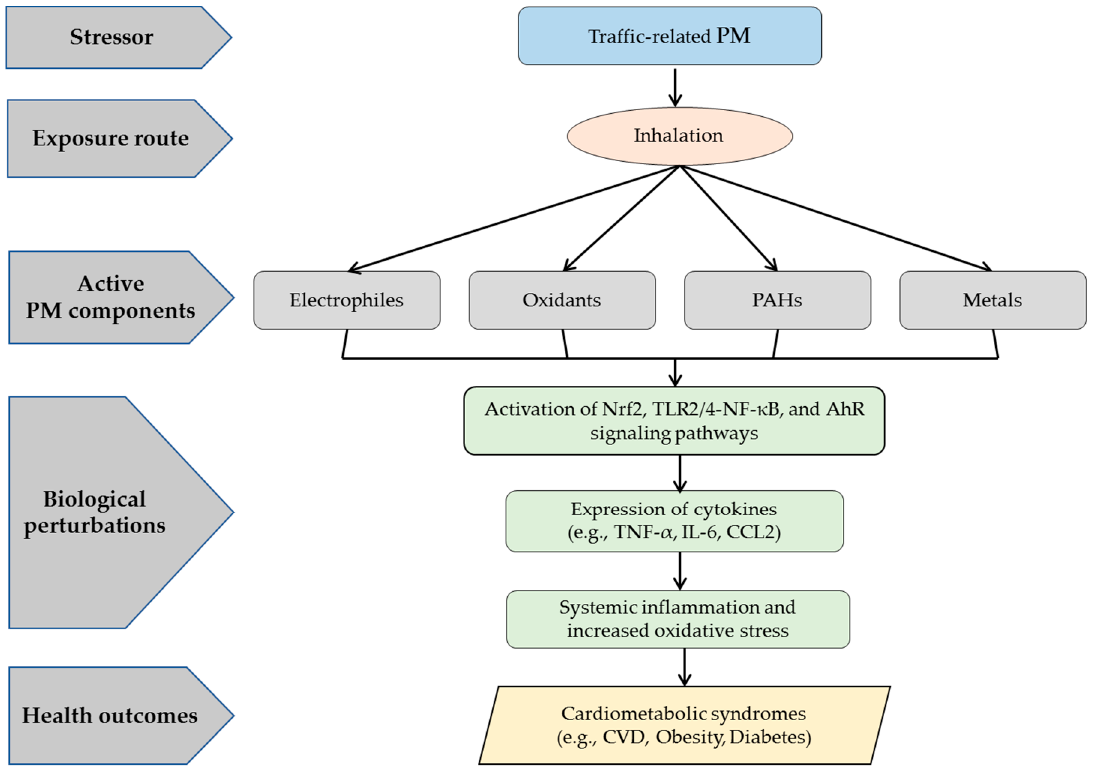
Figure 2. A conceptual diagram of traffic ‐ related particulate matter (PM) ‐ induced cardiometabolic syndrome ‐ connecting sources, exposure, biological perturbations, and outcomes.